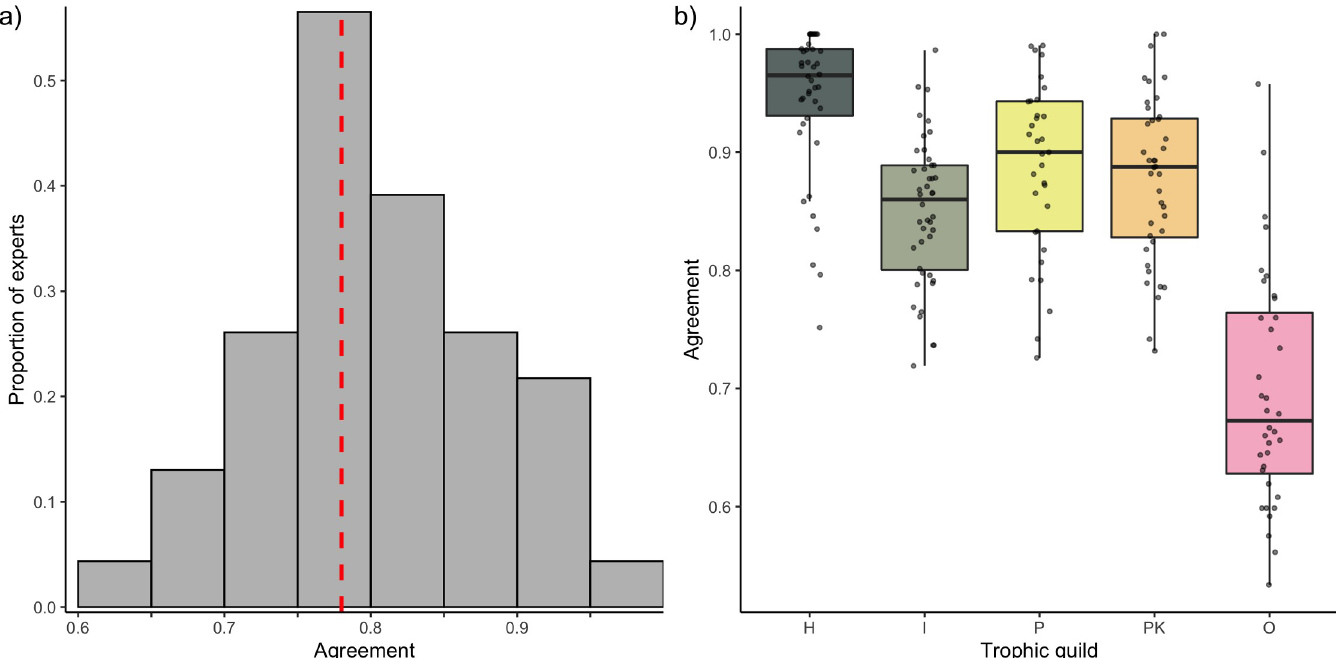
Fig 1. Expert agreement on trophic guild assignment. ( A ) The distribution of the agreement (i.e., proportion of species assigned to the same trophic category) across the 32 comparisons between pairs of experts. The red dotted line represents the median. ( B ) Agreement between pairs of experts by trophic category. The data underlying this figure may be found in https://github.com/valerianoparravicini/Trophic_Fish_2020. H , herbivores and detritivores; I , invertivores; O , omnivores; P , piscivores; PK , planktivores.